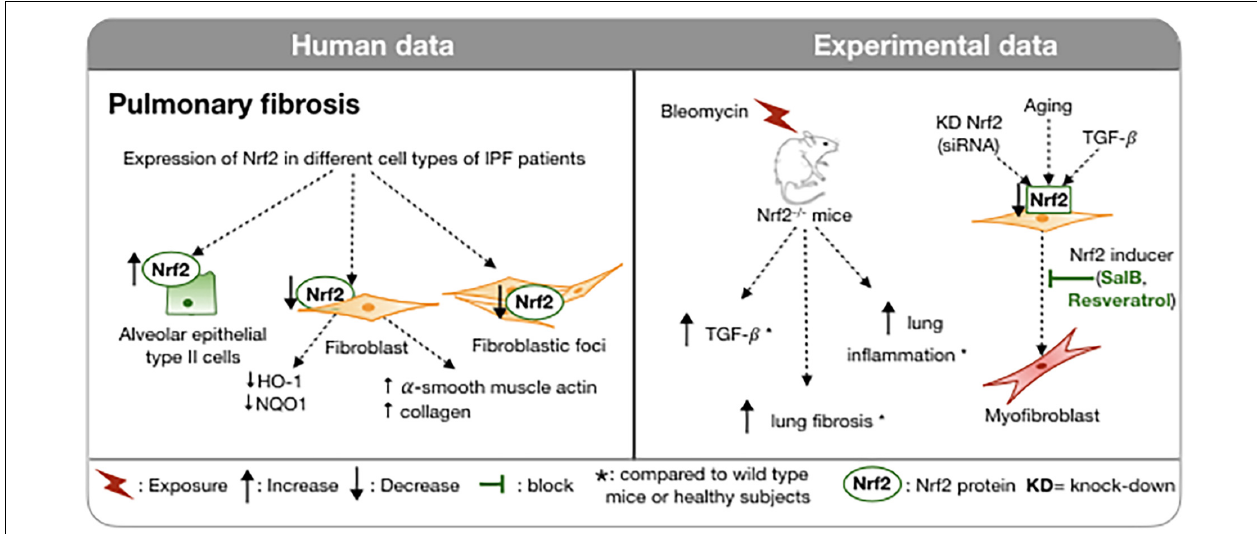
FIGURE 3 | Involvement of Nrf2 in IPF in humans and in experimental models. In IPF, Nrf2 expression varies between cells: increased in type II pneumocytes and reduced in fibroblasts and fibroblast foci. In a bleomycin-induced pulmonary fibrosis model, Nrf2-deficient mice exhibit more severe pulmonary fibrosis, increased TGF β and pulmonary inflammation compared to wild type mice. Downregulation of Nrf2 in fibroblasts induces myofibroblast differentiation. A Nrf2 inducer can inhibit this process. ↑ , Increase; ↓ , Decrease; , block; , exposure; *, compared to wild type mice or healthy subjects; KD, knock-down; WT, wild type.